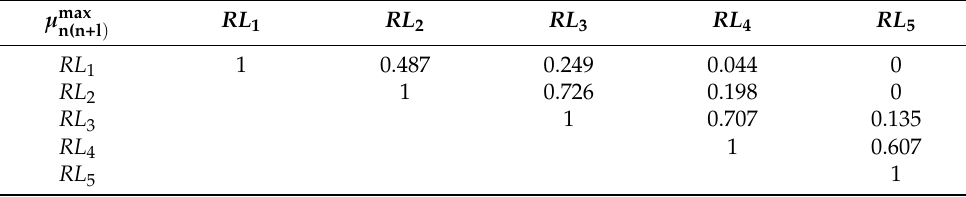
Figure 5. Fuzzy evaluation level of emergency risk in TBM tunnel construction. According to Figure 5, the maximum affiliation degree of the intersection of each evaluation level is obtained as shown in Table 10. Table 10. List of maximum membership degree of intersection of evaluation grades.